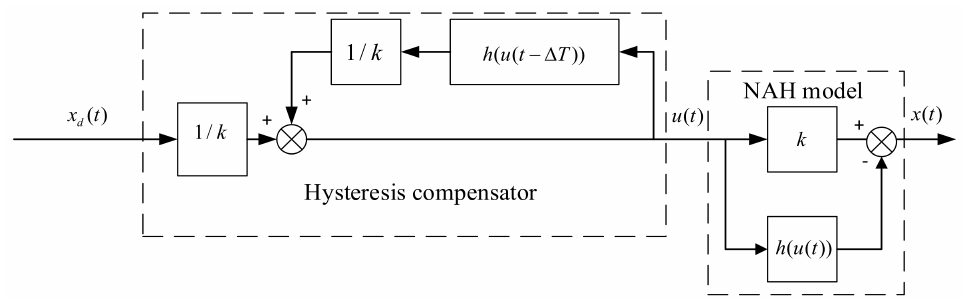
Figure 13. Block diagram of hysteresis compensator based on MBW model.